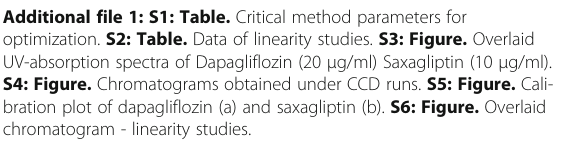
Additional file 1: S1: Table. Critical method parameters for optimization. S2: Table. Data of linearity studies. S3: Figure. Overlaid